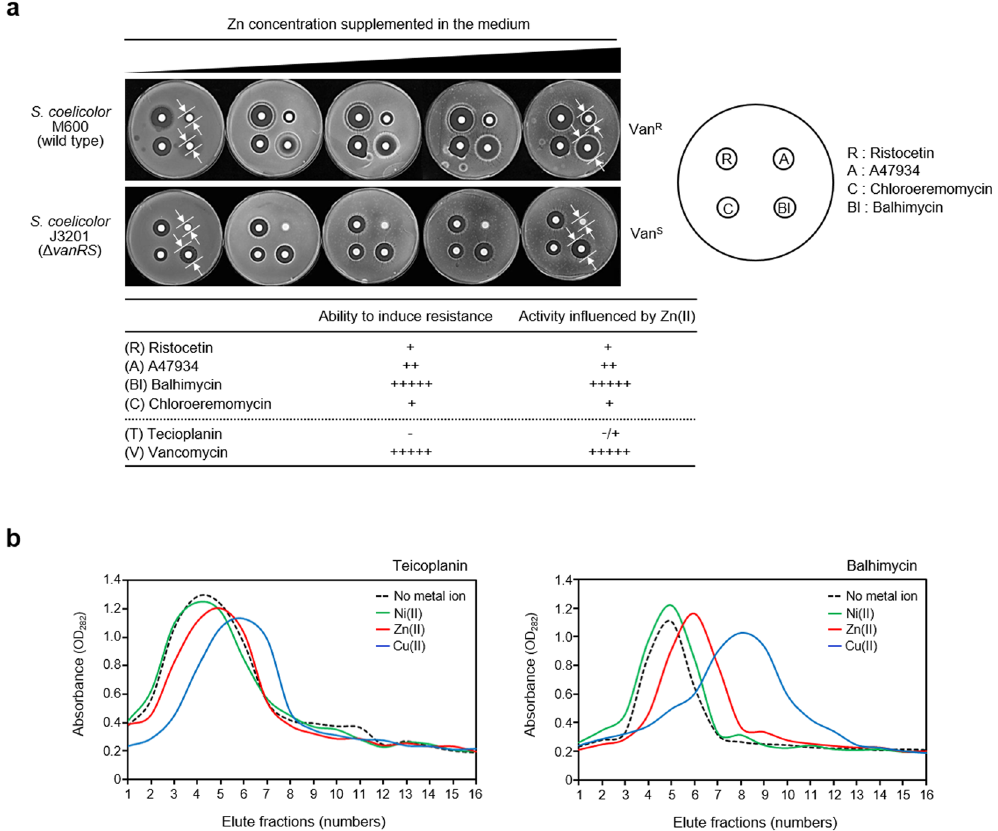
Figure 2. Zn(II) potentiates the activity of glycopeptide antibiotics that are both strong inducers for resistance and which interact with Zn(II). ( a ) The effect of Zn(II) on the activity of ristocetin (R), A47934 (A), chloroeremomycin (C) and balhimycin (Bl) against vancomycin-resistant and -sensitive S. coelicolor strains. The table summarizes the bioassay results shown above, presenting the influence of Zn(II) on antibiotic activity against an index summarizing the ability of each antibiotic to induce the VanS sensor in S. coelicolor , obtained from previous studies 13, 17–21 . ( b ) Metal affinity chromatography to measure the interaction of balhimycin and teicoplanin with Zn(II), Cu(II) or Ni(II). Elution of teicoplanin or balhimycin from the columns was quantified by the analysis of 0.5 ml fractions at OD 282 and a bioassay against a vancomycin sensitive S. coelicolor ∆ vanRS mutant strain (Supplementary Fig.